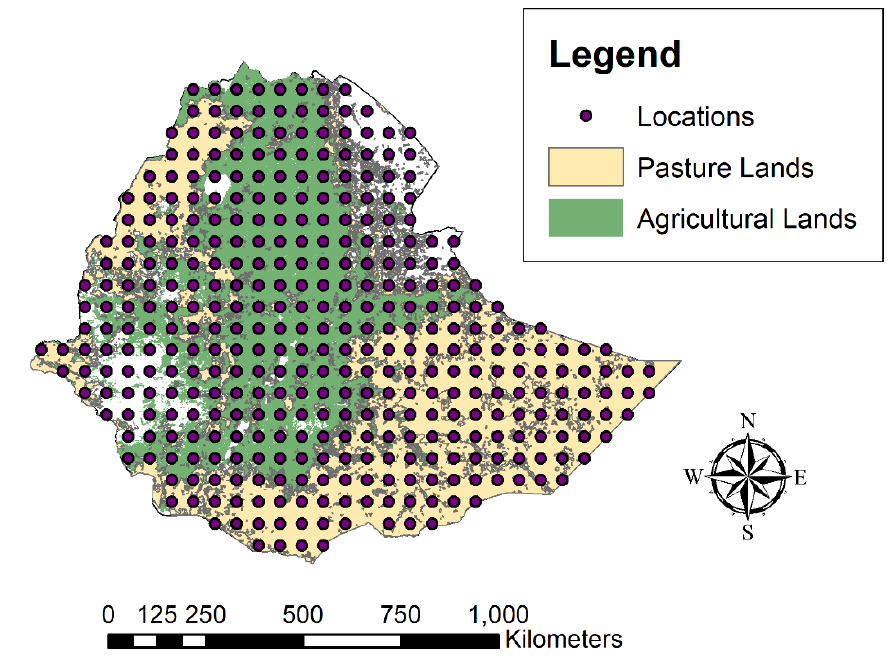
Figure 1. 0.5° × 0.5° grid used for evaluations of meteorological and agricultural droughts across Ethiopia overlaid on agricultural and pasture land.